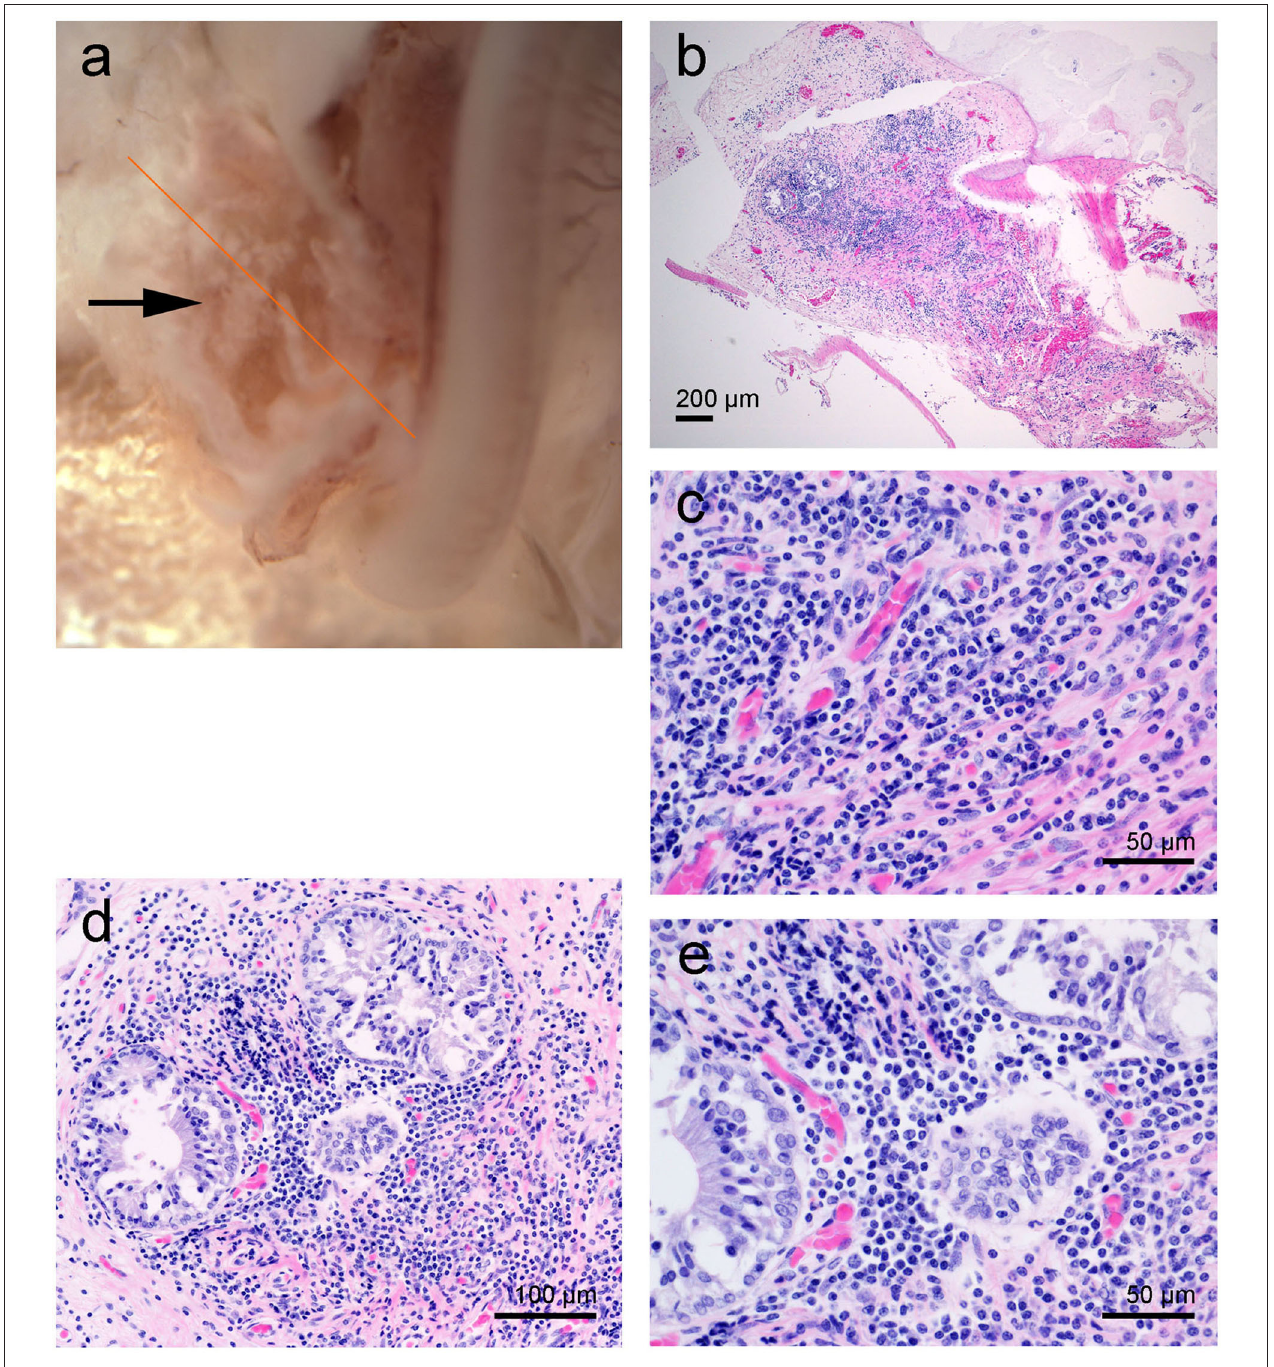
FIGURE 6 | Left cochlea from the beluga Aurora. (a) Sub-gross image of the base of the cochlea. The arrow highlights the white deposits at the round window niche. (b–d) Micrographs of Hematoxylin and Eosin stained sections with moderate focal accumulation of lymphocytes, plasma cells and fewer macrophages with scattered neutrophils. In images (d,e) there are a small number of entrapped variably sized